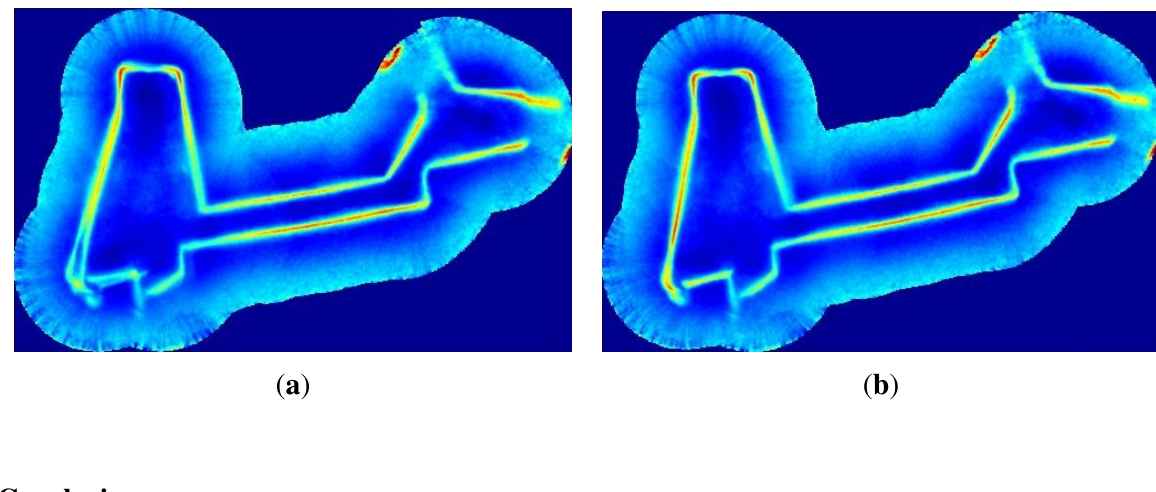
Figure 18. All the gathered acoustic images drawn according to ( a ) usICP; and ( b )